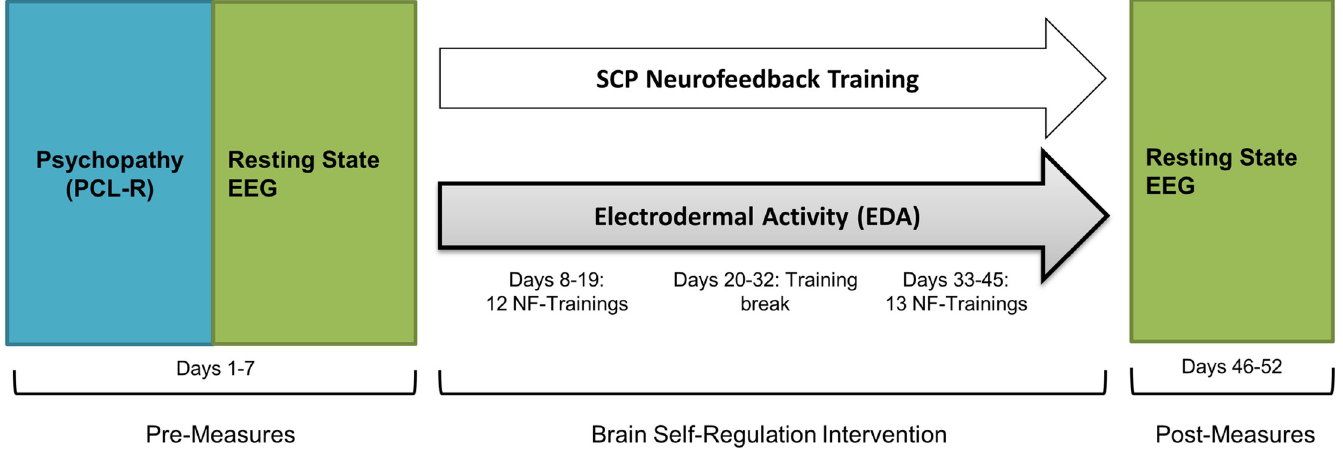
PLOS ONE | https://doi.org/10.1371/journal.pone.0242830 January 7,